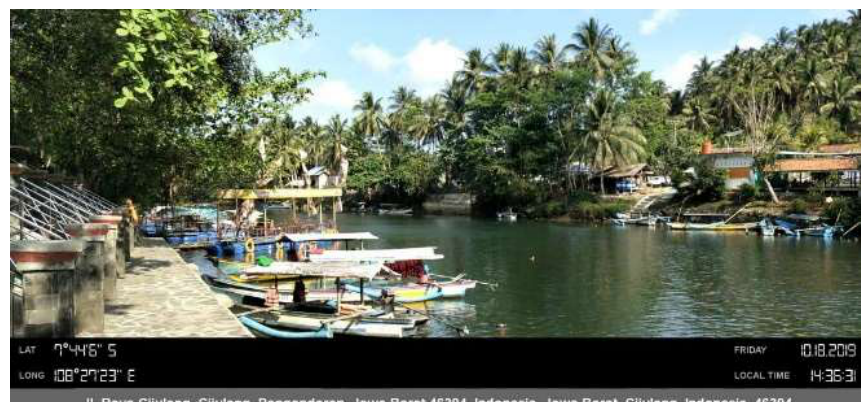
Figure 2. Green Canyon